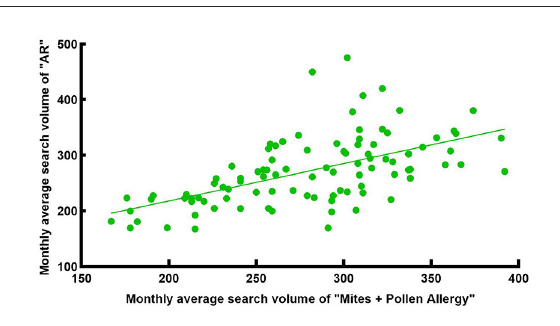
CI: [0.296, 0.901]], and 2014–2021 [0.554, P < 0.001, 95%CI: [0.391, 0.686]].